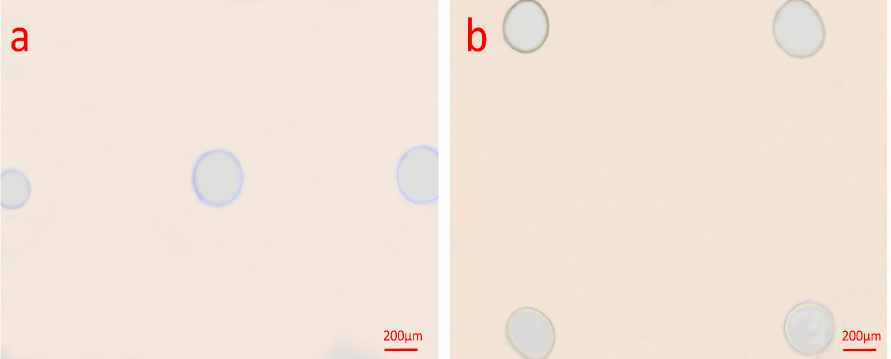
Figure 9. ( a , b ) Optical microscopy images of photoresist etched by plasma microjets array of 1 × 3 and 2 × 2. The diameter of the microholes from left to right in ( a ) was 196, 251, and 266 µ m; diameters in ( b ) were 251, 268, 253, and 258 µ m. Experiment conditions: 700 sccm helium gas and 28 sccm additive oxygen at an applied voltage of 7.5 kV pp and 8.5 kV pp , the frequency was around 11 kHz, the distance was 1 mm.